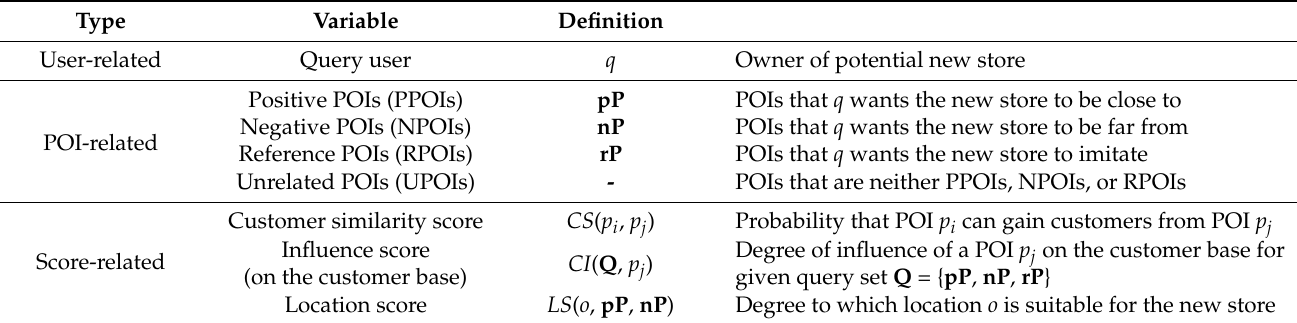
Table 2. Definition of